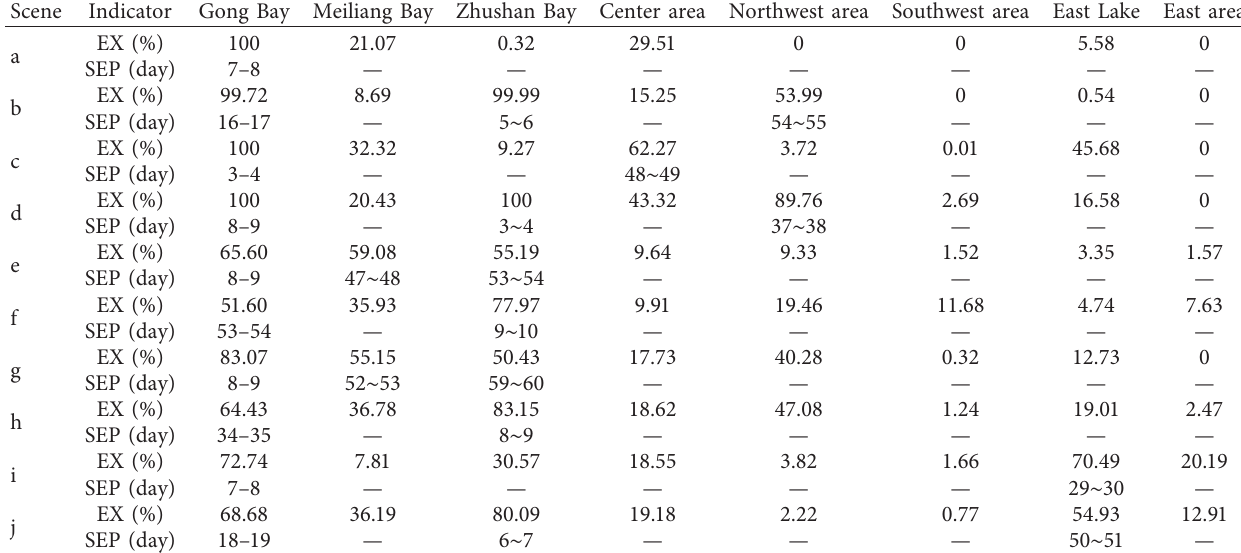
Table 3: Water exchange rate and the semiexchange period of eight lake districts under ten operating modes. Scene Indicator